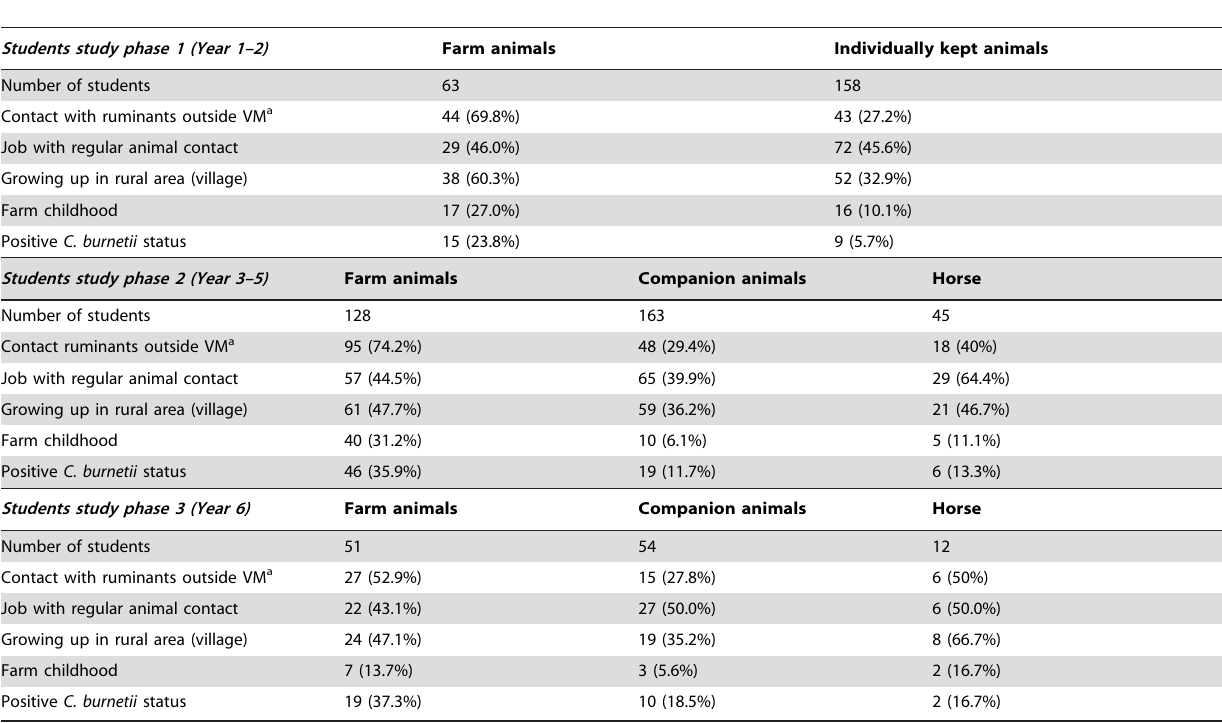
Table 3. Characteristics of students (n (%) or stated otherwise) who provided blood for the different study phases and by study